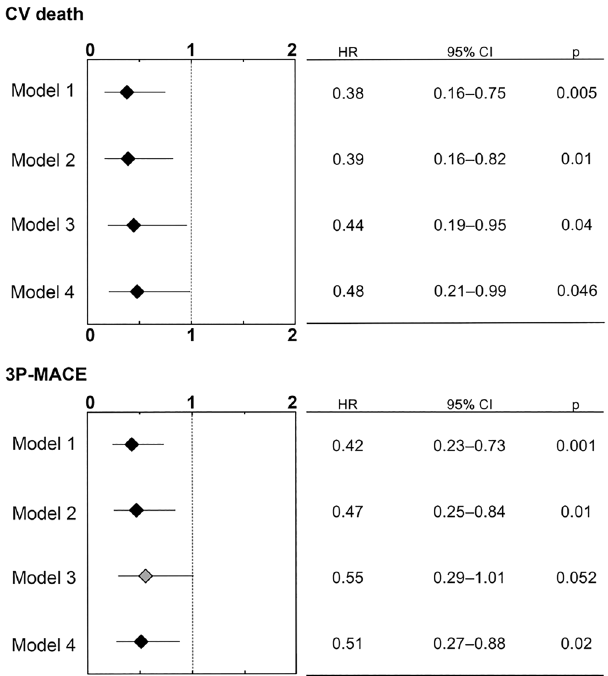
Figure 2. Prognostic impact of DPP4i at PCI for adverse cardiovascular events in 4 Cox proportional hazard models. Hazard ratios were calculated by multivariate Cox proportional hazard analyses by using 4 different models. Model 1: age, sex and DPP4i, Model 2: age, sex, body mass index (BMI), chronic kidney disease (CKD), b-type natriuretic peptide (BNP), insulin and DPP4i, Model 3: age, sex, acute coronary syndrome (ACS), left ventricular ejection fraction (LVEF), statins, hemoglobin and DPP4i, Model 4: metformin, sulfonylurea, alpha-glucosidase inhibitors, thiazolidinedione, glinide, insulin and DPP4i. HR hazard ratio, 95% CI confidence interval.